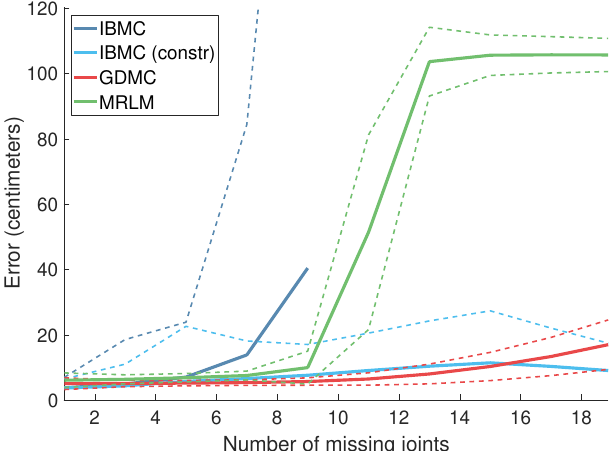
Figure 6. Error as a function of the number of missing joints. The dashed plots represent the standard deviation of the respective